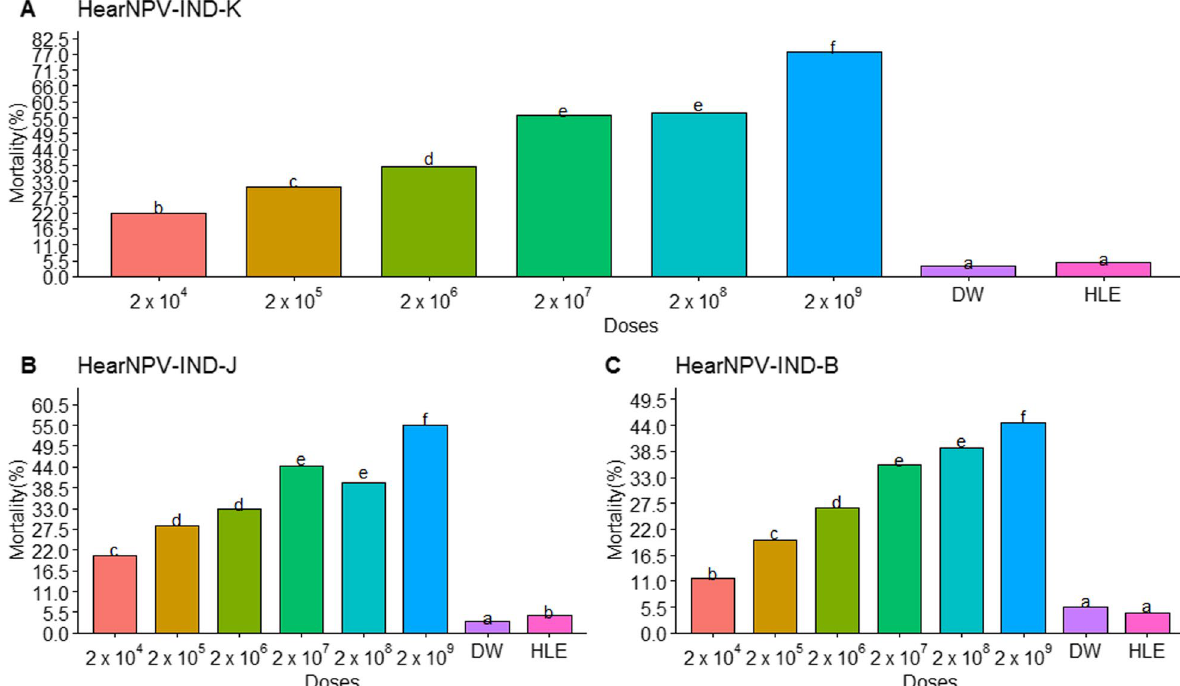
Fig. 2 Comparative mortality (%) of three different HearNPV isolates against Helicoverpa armigera larvae on tomato plants under field conditions (DW Distilled water; HLE Healthy larval extract). The highest mortality of 77.82% was observed with the HearNPV-IND-K isolate at a = = concentration of 2 10 9 ×